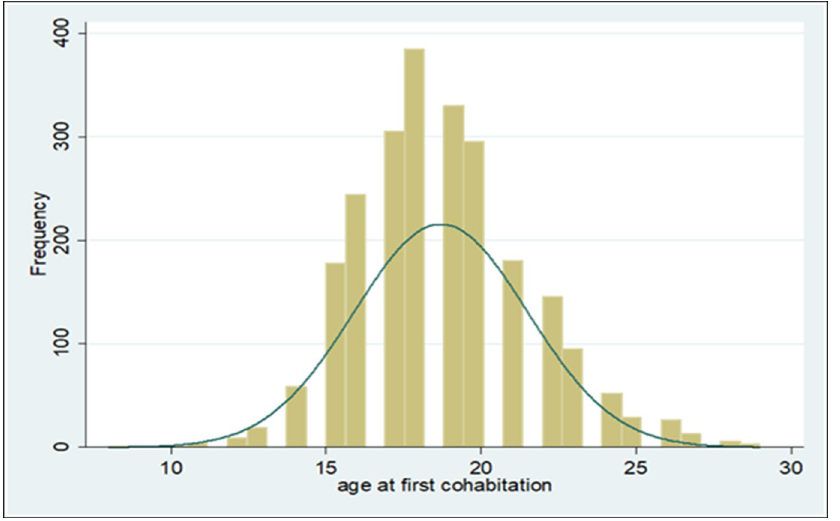
Fig 1. Sample distribution of age at first